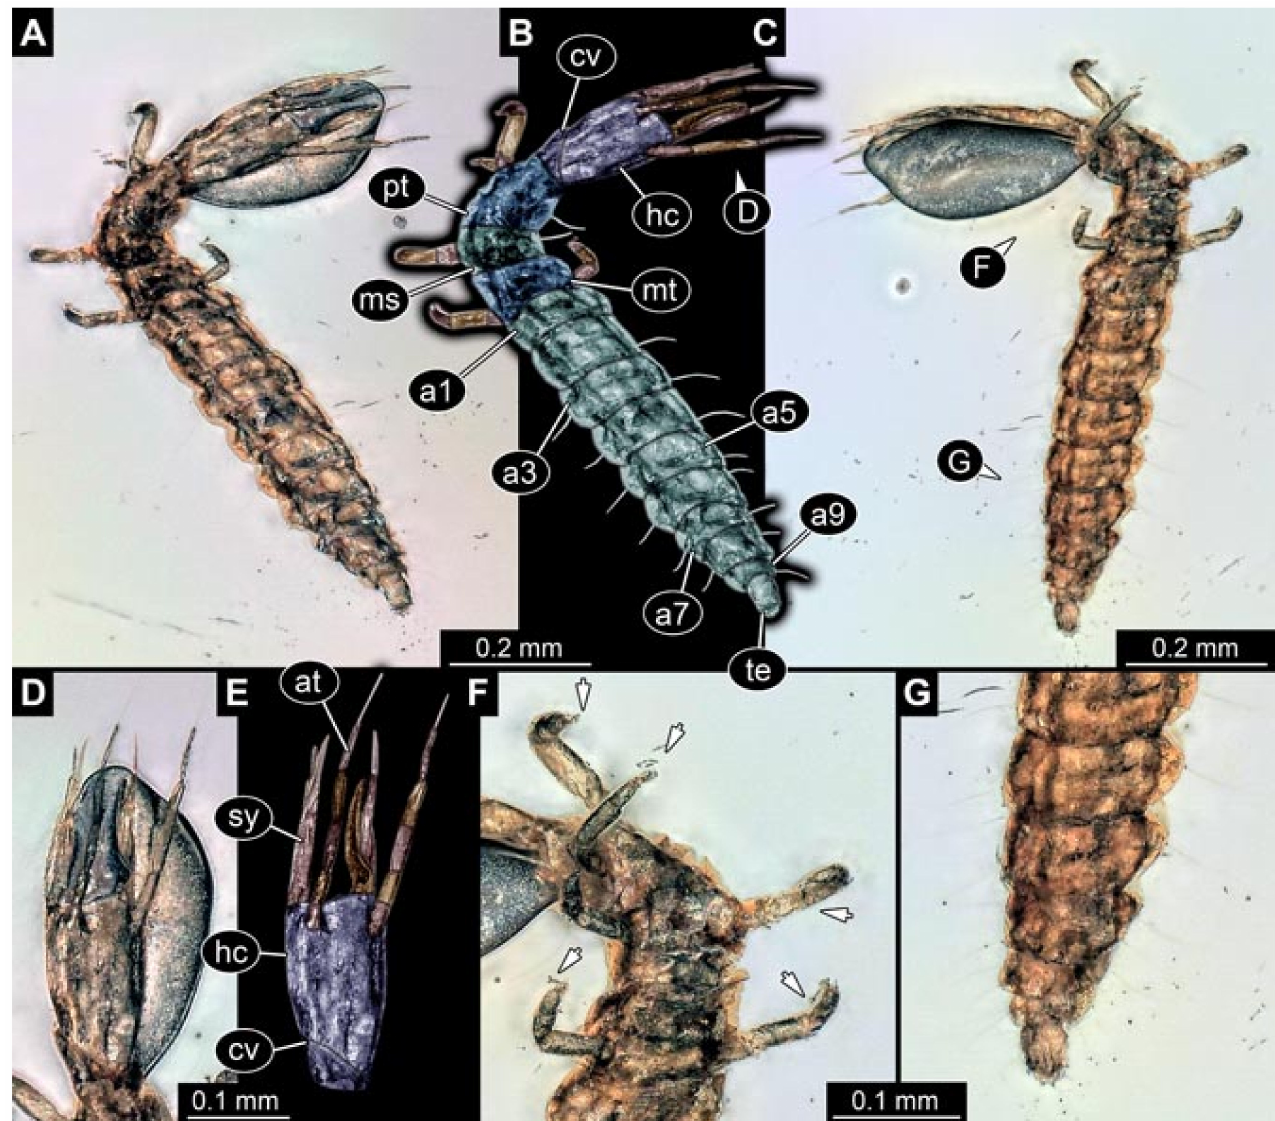
Figure 8. Specimen 5829 (BUB 3726); Myanmar amber. ( A ) Dorsal view. ( B ) Dorsal view, colour-marked. ( C ) Ventral view. ( D ) Close-up of head in dorsal view. ( E ) Close-up of head in dorsal view, colour-marked. ( F ) Close-up of trunk appendages with empodia (arrows). ( G ) Close-up of trunk end in ventral view. Abbreviations: a1–a9 = abdomen segments 1–9; at = antenna; cv = cervix; hc = head capsule; ms = mesothorax; mt = metathorax; pt = prothorax; sy = stylet; te = trunk